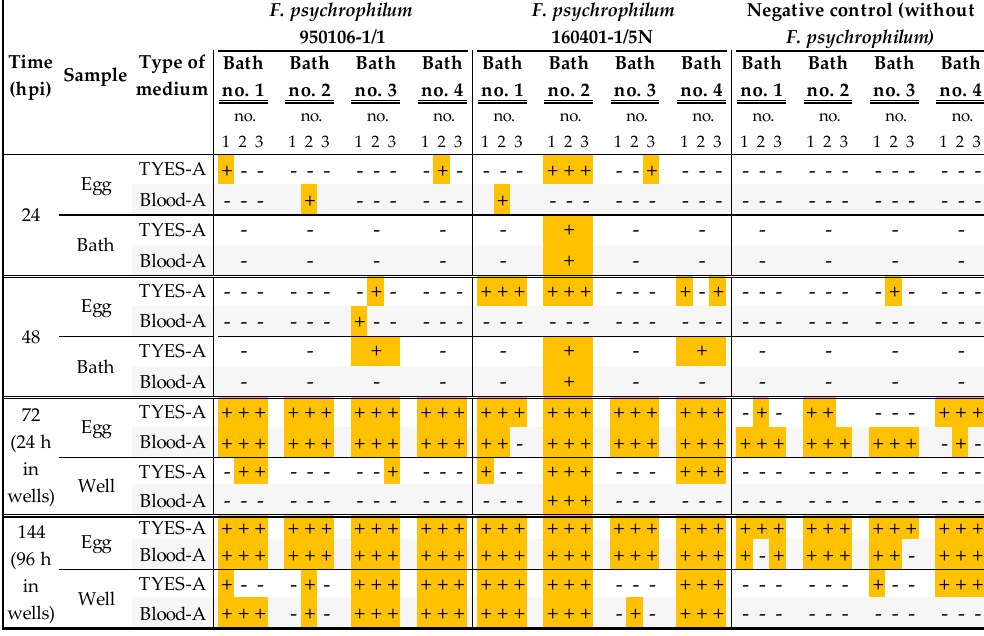
Figure A4. Exp. I section C: bacterial growth other than F. psychrophilum in sampled eyed eggs and the corresponding bath/wells was recorded. A plus symbol with an orange background indicates a positive detection of bacterial colonies in TYES-B and/or on Blood-A (“-” = no growth). Bath no. 1: phage bath with of 10 9 PFU mL − 1 ; Bath no. 2: phage bath with 10 8 PFU mL − 1 ; Bath no. 3: control bath with SM buffer; Bath no. 4: control bath with Milli-Q water.